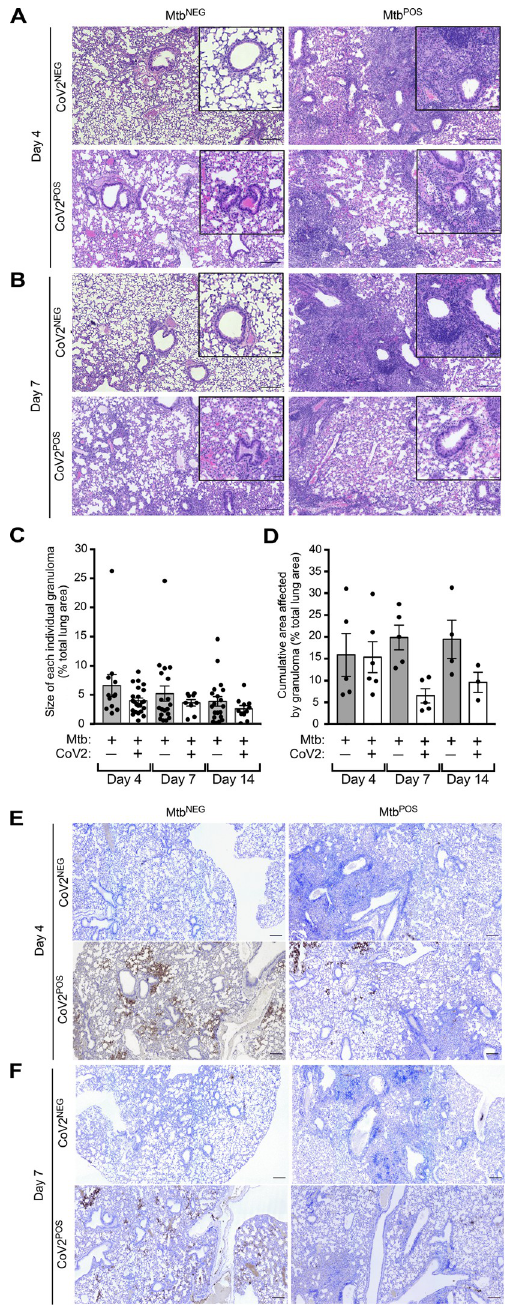
Fig 3. CoV2 infection of the airways and associated pneumonia are attenuated in the presence of Mtb. (A-B) Representative micrographs of H&E stained lung sections, sections from each experimental group, as collected on ( A ) Day 4 or ( B ) Day 7 post challenge. ( C-D ) Quantitative analysis of H&E stains demonstrating ( C ) the size of each individual TB granuloma relative to the total lung area, with each dot representing an individual TB granuloma on the indicated Days, as well as ( D ) the cumulative area taken up by all granulomas in an individual mouse lung, with each dot representing an individual mouse on the indicated Days. Bars represent the mean +/- SD. (E-F) Representative micrographs of CoV2 N protein IHC stained lung sections from each experimental group, as collected on ( E ) Day 4 or ( F ) Day 7 post challenge. In each micrograph the large scale bar represents 200 microns; insets are 50 microns.